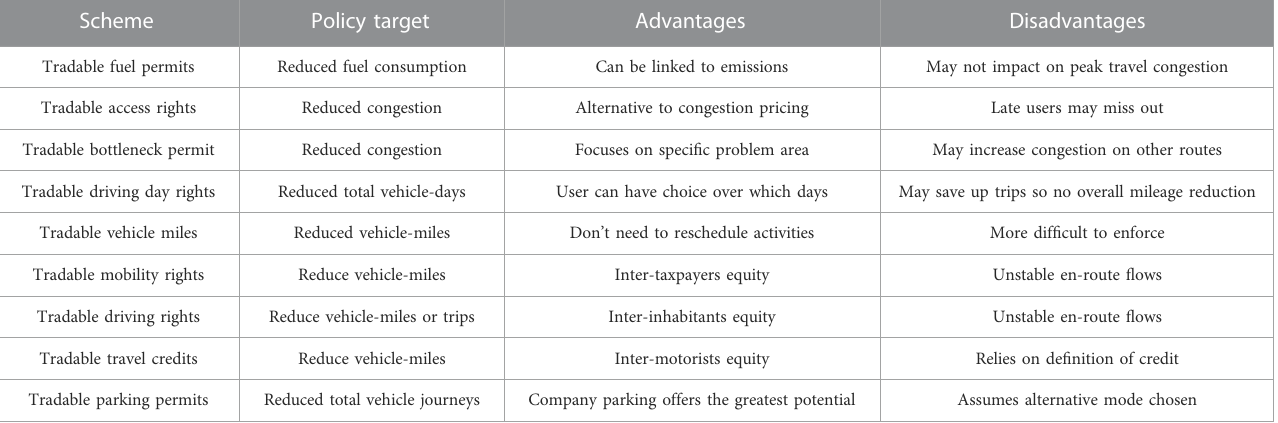
TABLE 1 User-Oriented tradable permit road transport schemes [based on (Verhoef et al., 1997; Fan and Jiang, 2013; Grant-Muller and Xu, 2014)].